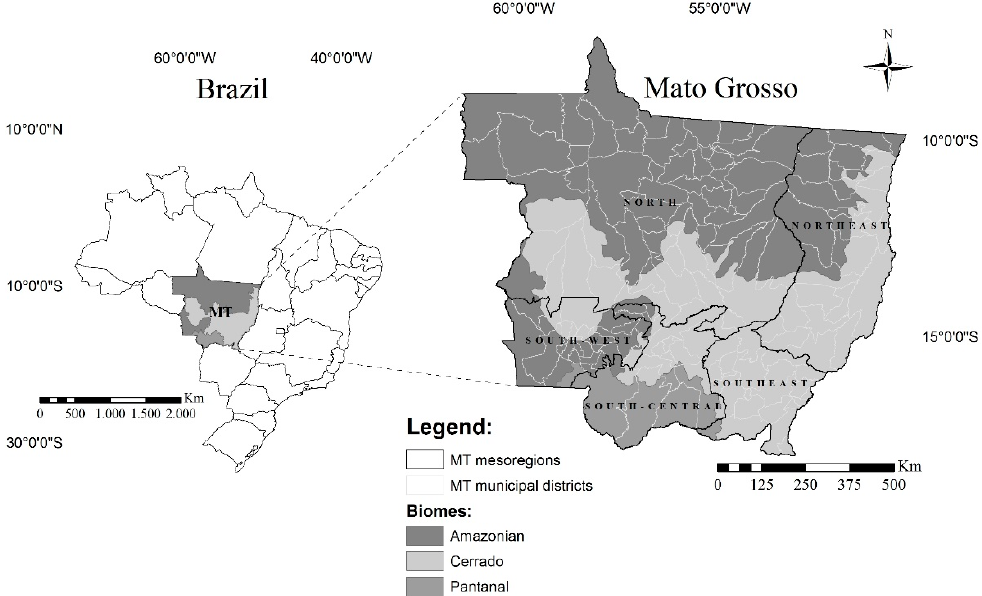
Figure 1. Geographic location of the State of Mato Grosso, Brazil, with its mesoregions and biomes. Source: Brazilian Institute of Geography and Statistics (IBGE) (2017).